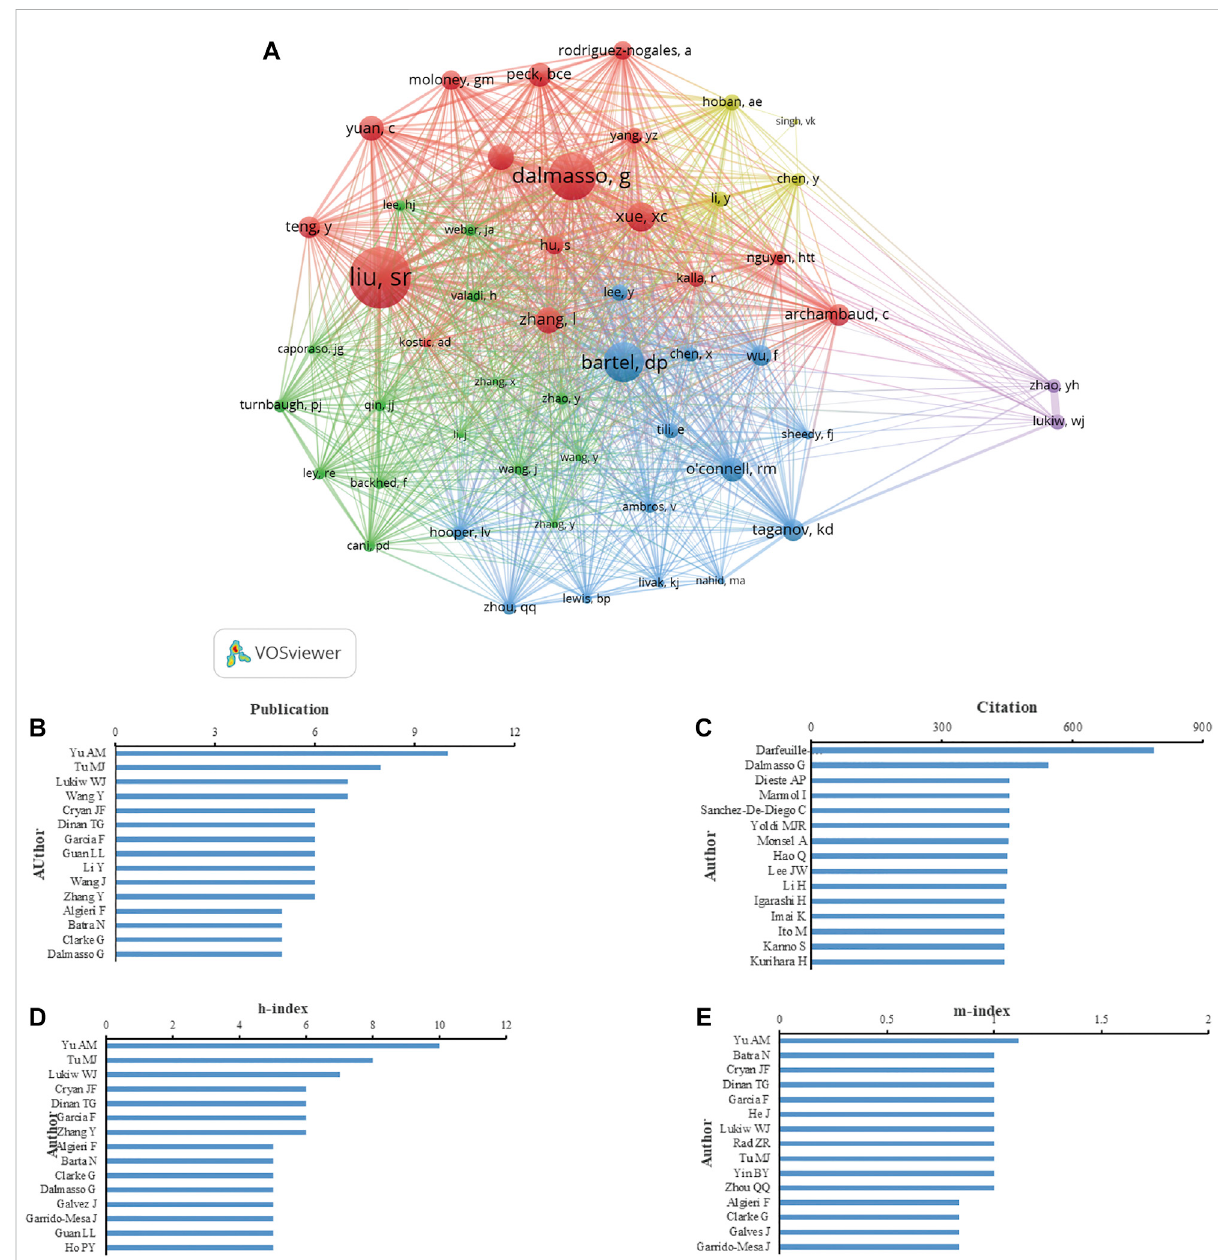
FIGURE 5 Analysis ofauthors focus on miRNA-microbiome interaction research. (A) VOSviewer ’ snetwork analysis of authors ’ co-citation with more than 25 citations by VOSviewer. (B) Top 15 authors in the number of publications. (C) Top 15 authors in total citations. (D) Top 15 authors in h-index of publications. (E) Top 15 authors in m-index of